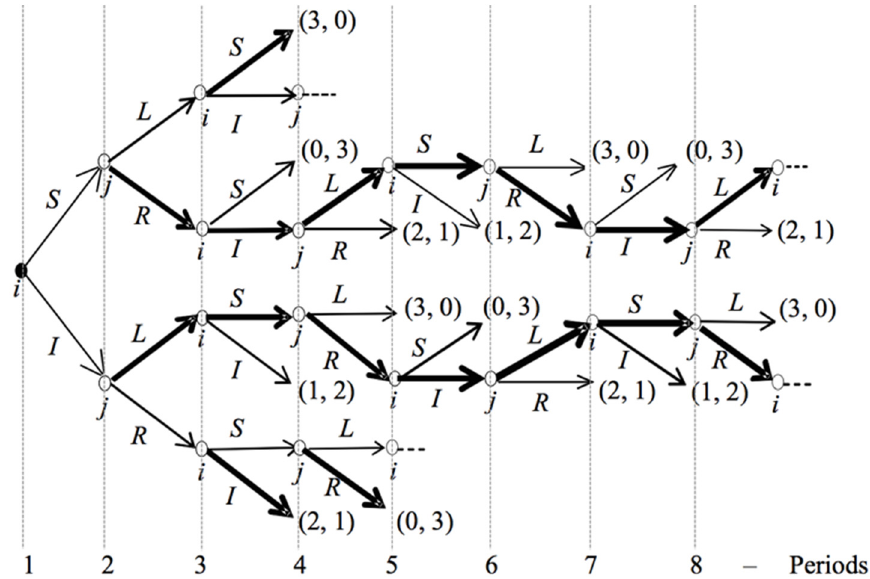
Figure 4. CP ( G ), G being the original game in Figure 3, with i as first